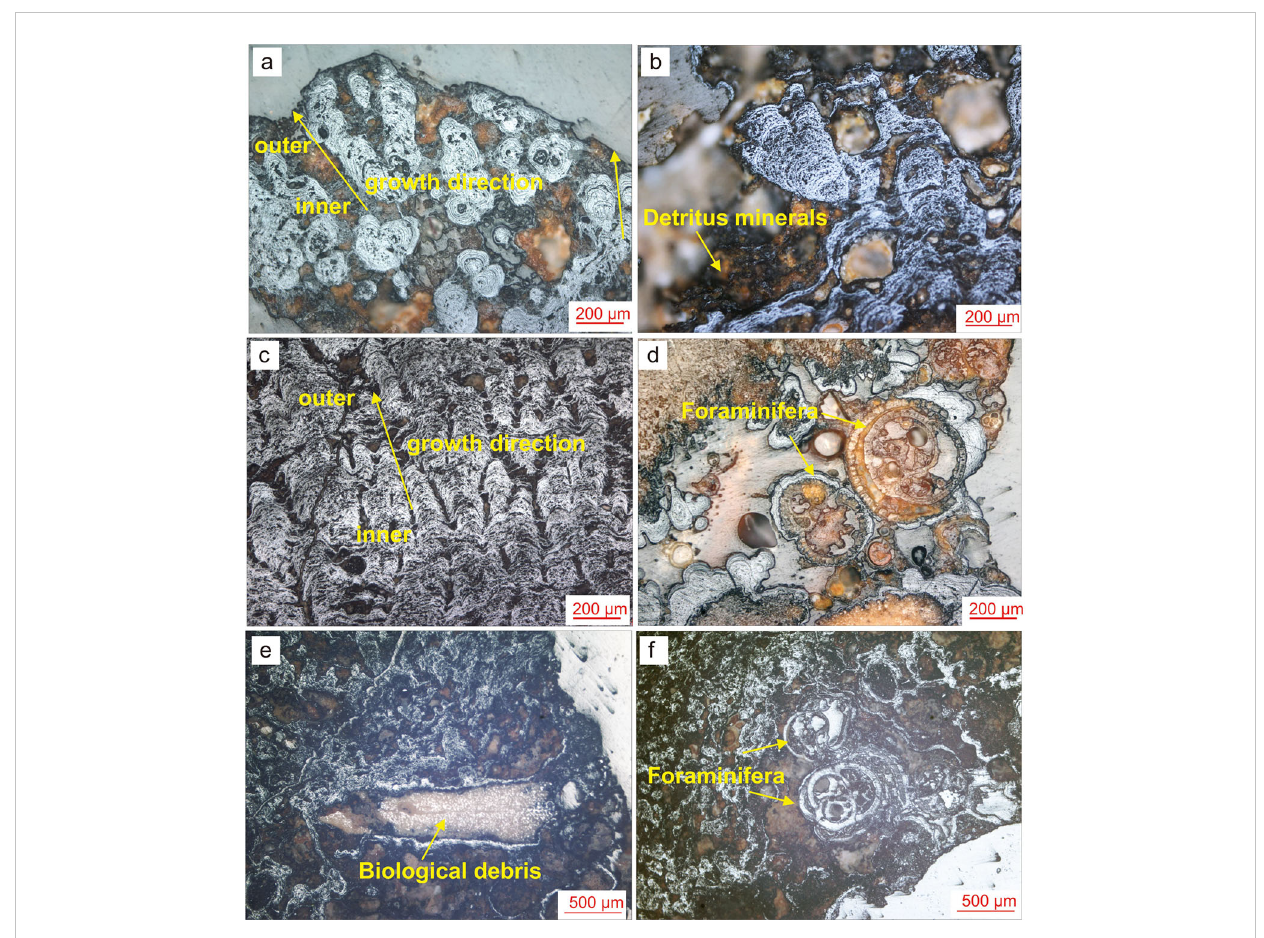
FIGURE 3 Photos of secondary growth structures of the SCS polymetallic crusts and nodules (A) concentric circle micro-nodules and columnar structure; (B) palmar-print structure; (C) dendritic structure; (D – F) biological debris and foraminifera in the